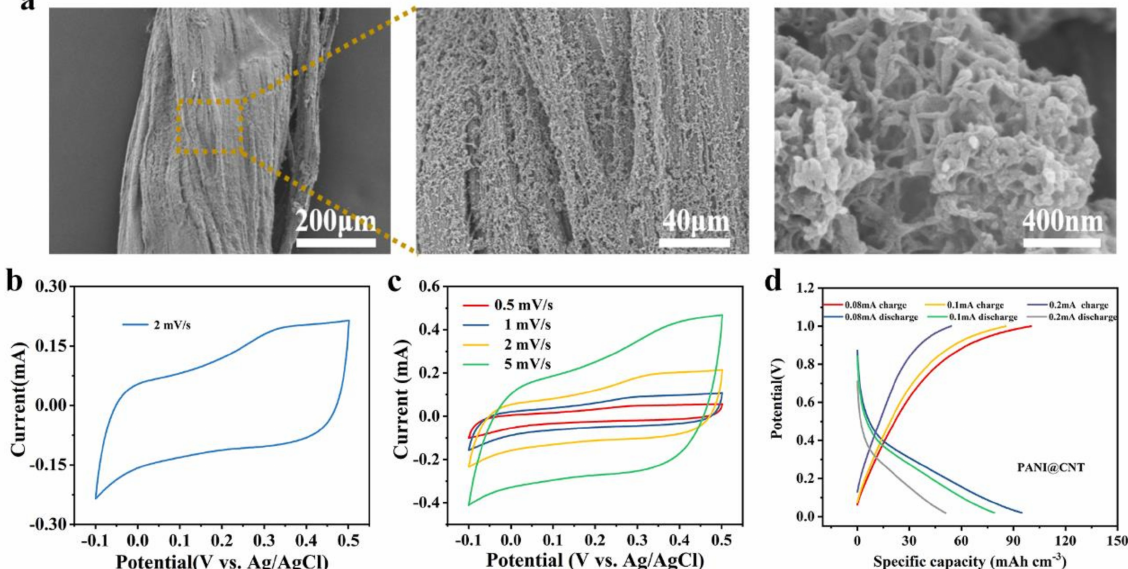
Figure 5. Characterization of the PANI@CNT fiber: ( a ) the morphology of PANI at different magnifi- cations; ( b ) CV curve of PANI@CNT fiber at a scan rate of 2 mV s − 1 ; ( c ) CV curves of PANI@CNT fiber at different scan rates; ( d ) GCD curves of PANI@CNT fiber at different current